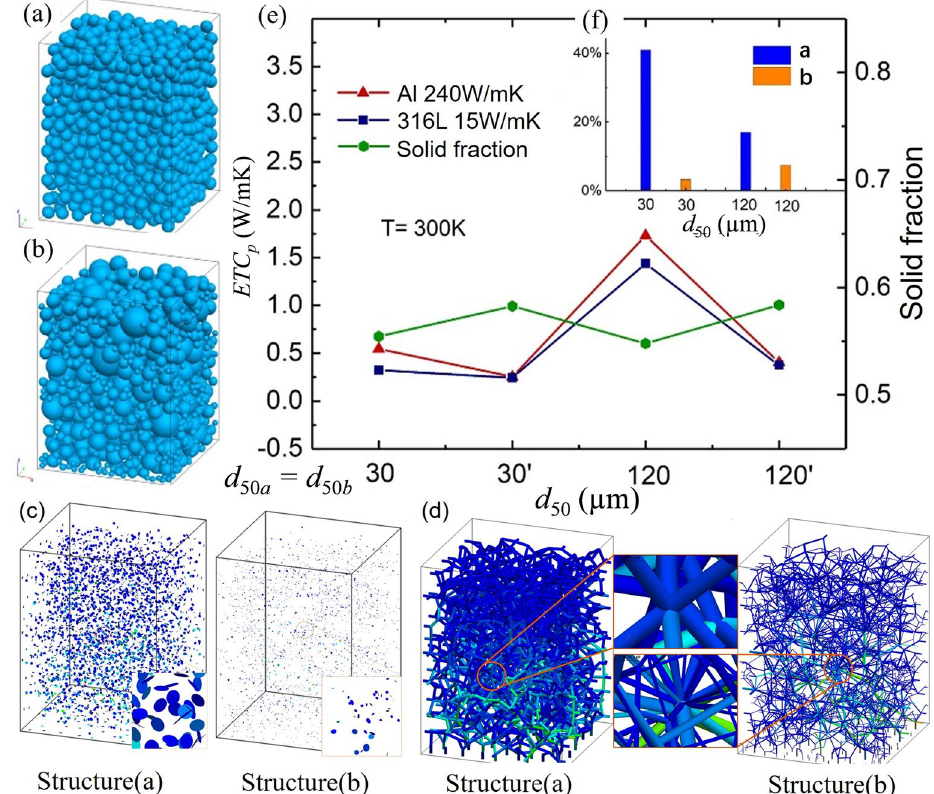
Figure 5 Comparison of ETC p results of equal particle size but different particle size distribution powder: a Model of unequal size powder; b Model of equal size powder; c Discoid display of contact surface of two kinds of stacking structures; d Columnar display of contact surface of two kinds of stacked structures; e The change of packing density of equal and unequal size packing structure, and the trend of ETC p when TC s changes; f The relative change of ETC p in a-stacking structure and b-stacking structure when the materials changes respectively